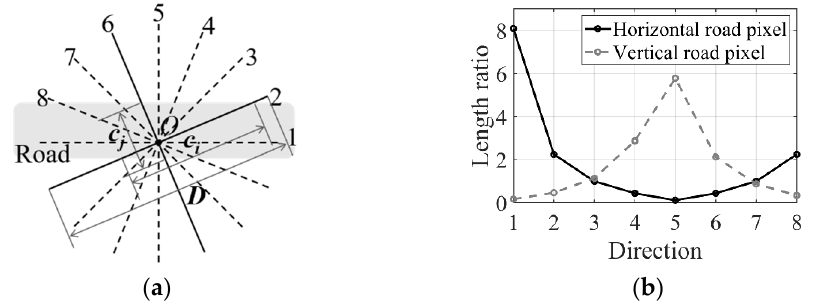
Figure 2. RoC detector. ( a ) Sketch map of RoC detector ( N = 8). ( b ) Length ratios for sampled horizontal and vertical road pixels at different directions.